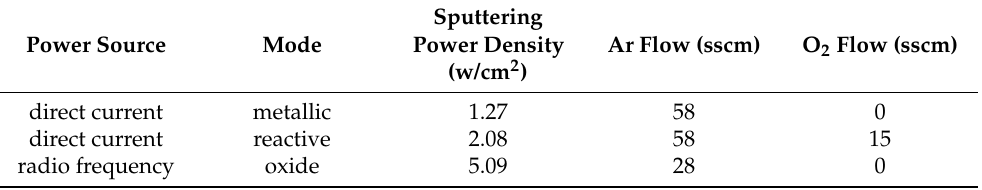
Table 1. Sputtering deposition